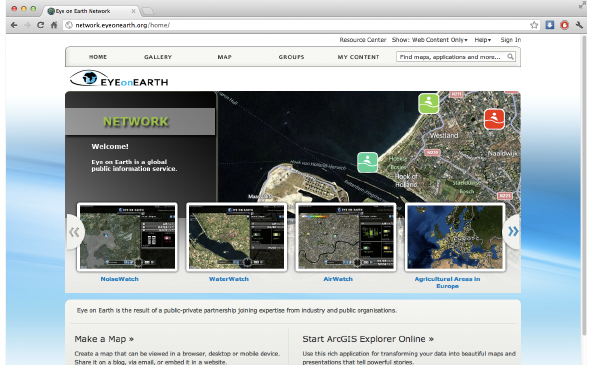
Figure 7. Eye on Earth